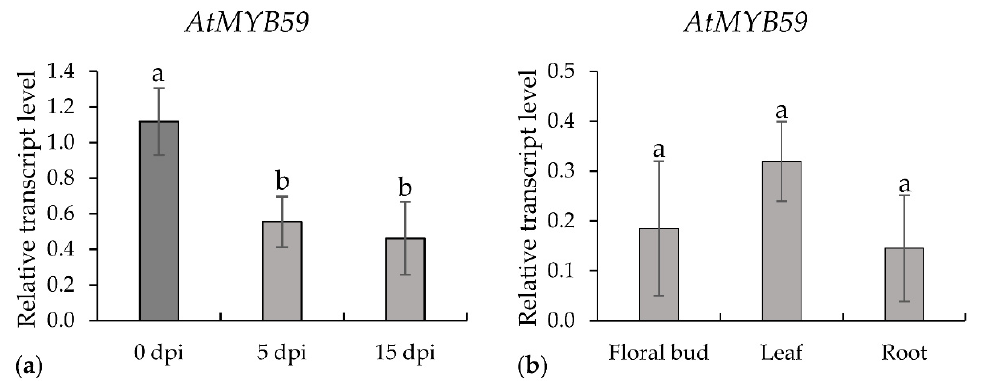
Figure 1. The relative expression levels of AtMYB59 in syncytia induced by H. schachtii in wild-type A. thaliana : ( a ) relative transcript levels of AtMYB59 in roots at 0, 5 and 15 dpi; and ( b ) relative transcript levels of AtMYB59 in floral buds, leaves and roots of one-month-old plants. The bars show mean values ± standard deviation. a, b homogenous groups. ( p < 0.05; ANOVA;